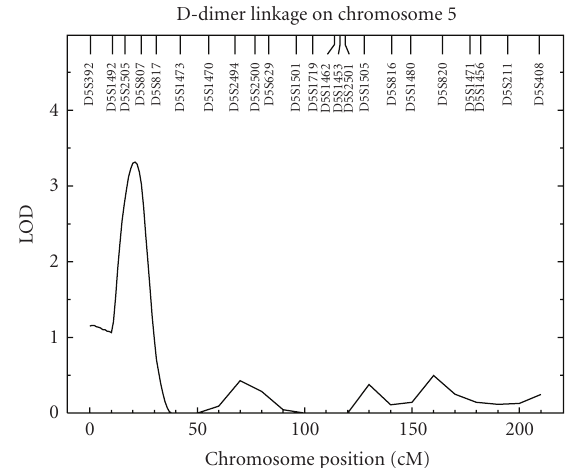
Figure 2: Linkage analysis results for D-dimer levels on chromo- some 5. Axes are as in Figure